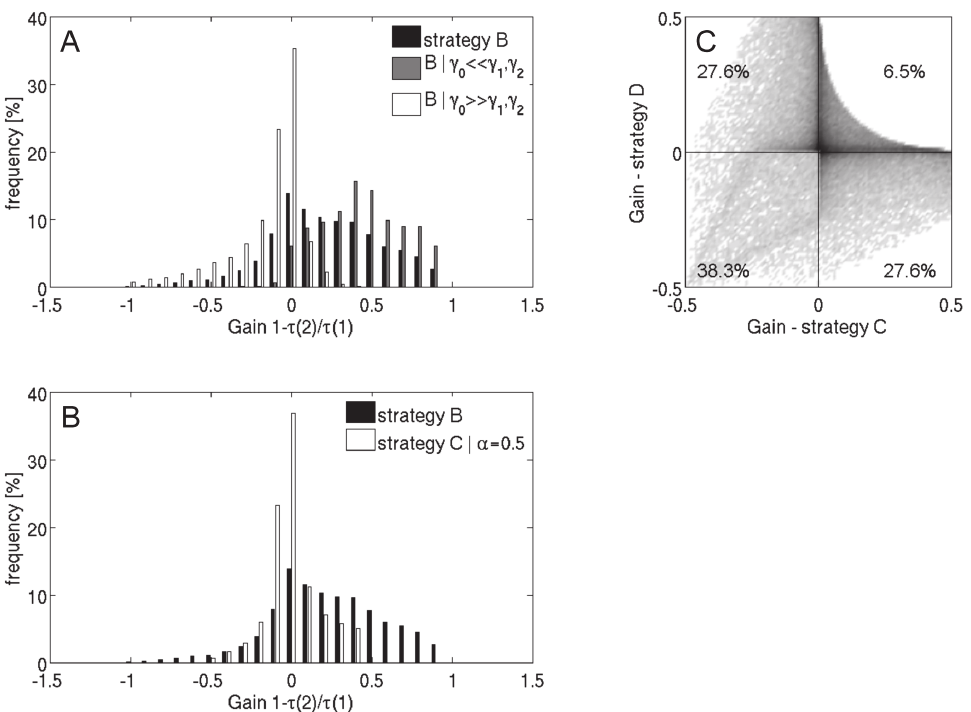
Fig 2. Frequency distribution of the gain achievable with strategies B or C relative to strategy A. The computation of the gain G 1 = 1 − τ (2)/ τ (1) was carried out for 20000 trials, where the turnover number, molecular mass and expression efficiencies of the three enzymes were randomly varied in the range [10 − 1 ; 10], while the free amino acids were neglected by setting γ A = 0. A) Strategy B, black bars, all parameters randomly varied; strategy B, white bars, relative molar masses set to: γ 0 = 100, γ 1 = γ 2 = 1; strategy B, gray bars, relative molar masses set to: γ 0 = 1, γ 1 = γ 2 = 100 B) Strategy B, black bars, all parameters randomly varied; strategy C, white bars, all parameters randomly varied and α = 0.5. C) Density plot of gain of strategy C versus the gain of strategy